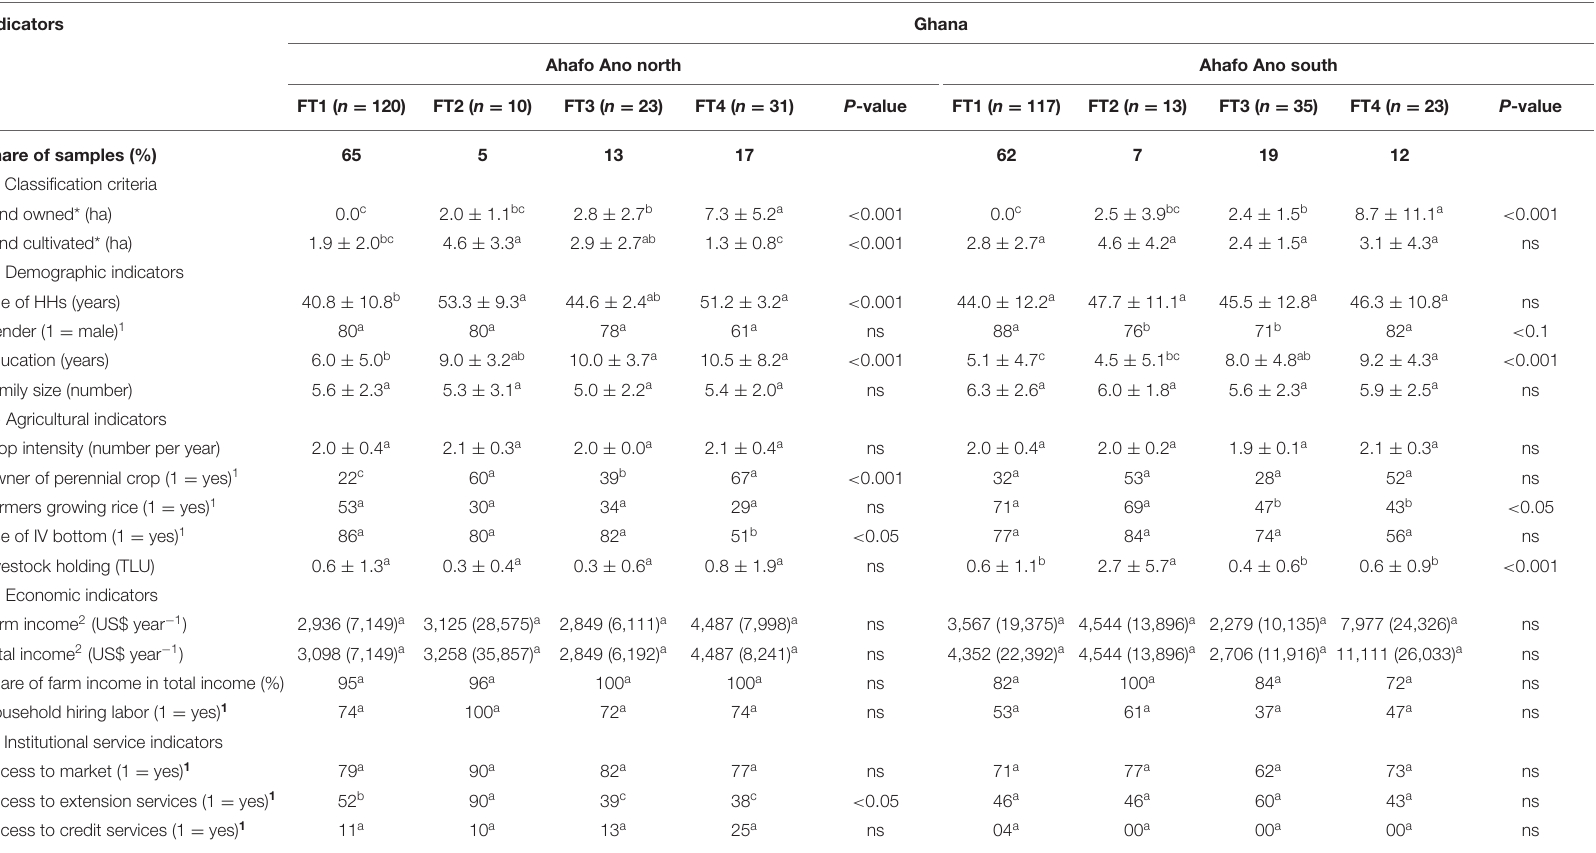
TABLE 6 | Farm household indicators (proportion and means ± standard deviation) for the four farm types in selected regions of Ghana, based on the RHoMIS household baseline survey (2018–2019). Indicators Ghana Ahafo Ano north Ahafo Ano